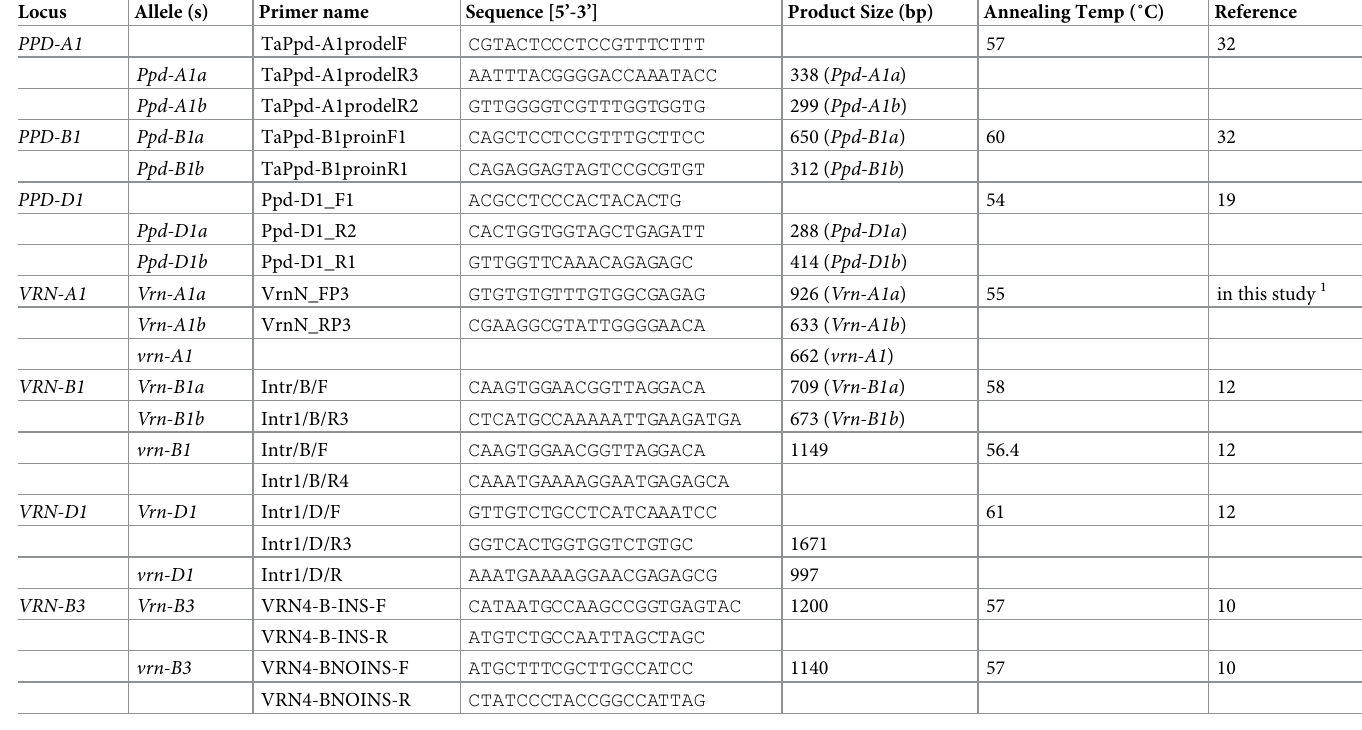
Table 1. Allele-specific markers for alleles at the major vernalization and photoperiod response genes, primer sequence, PCR product size, annealing temperature and citation for the markers used in this study for the use of genotyping. Locus Allele